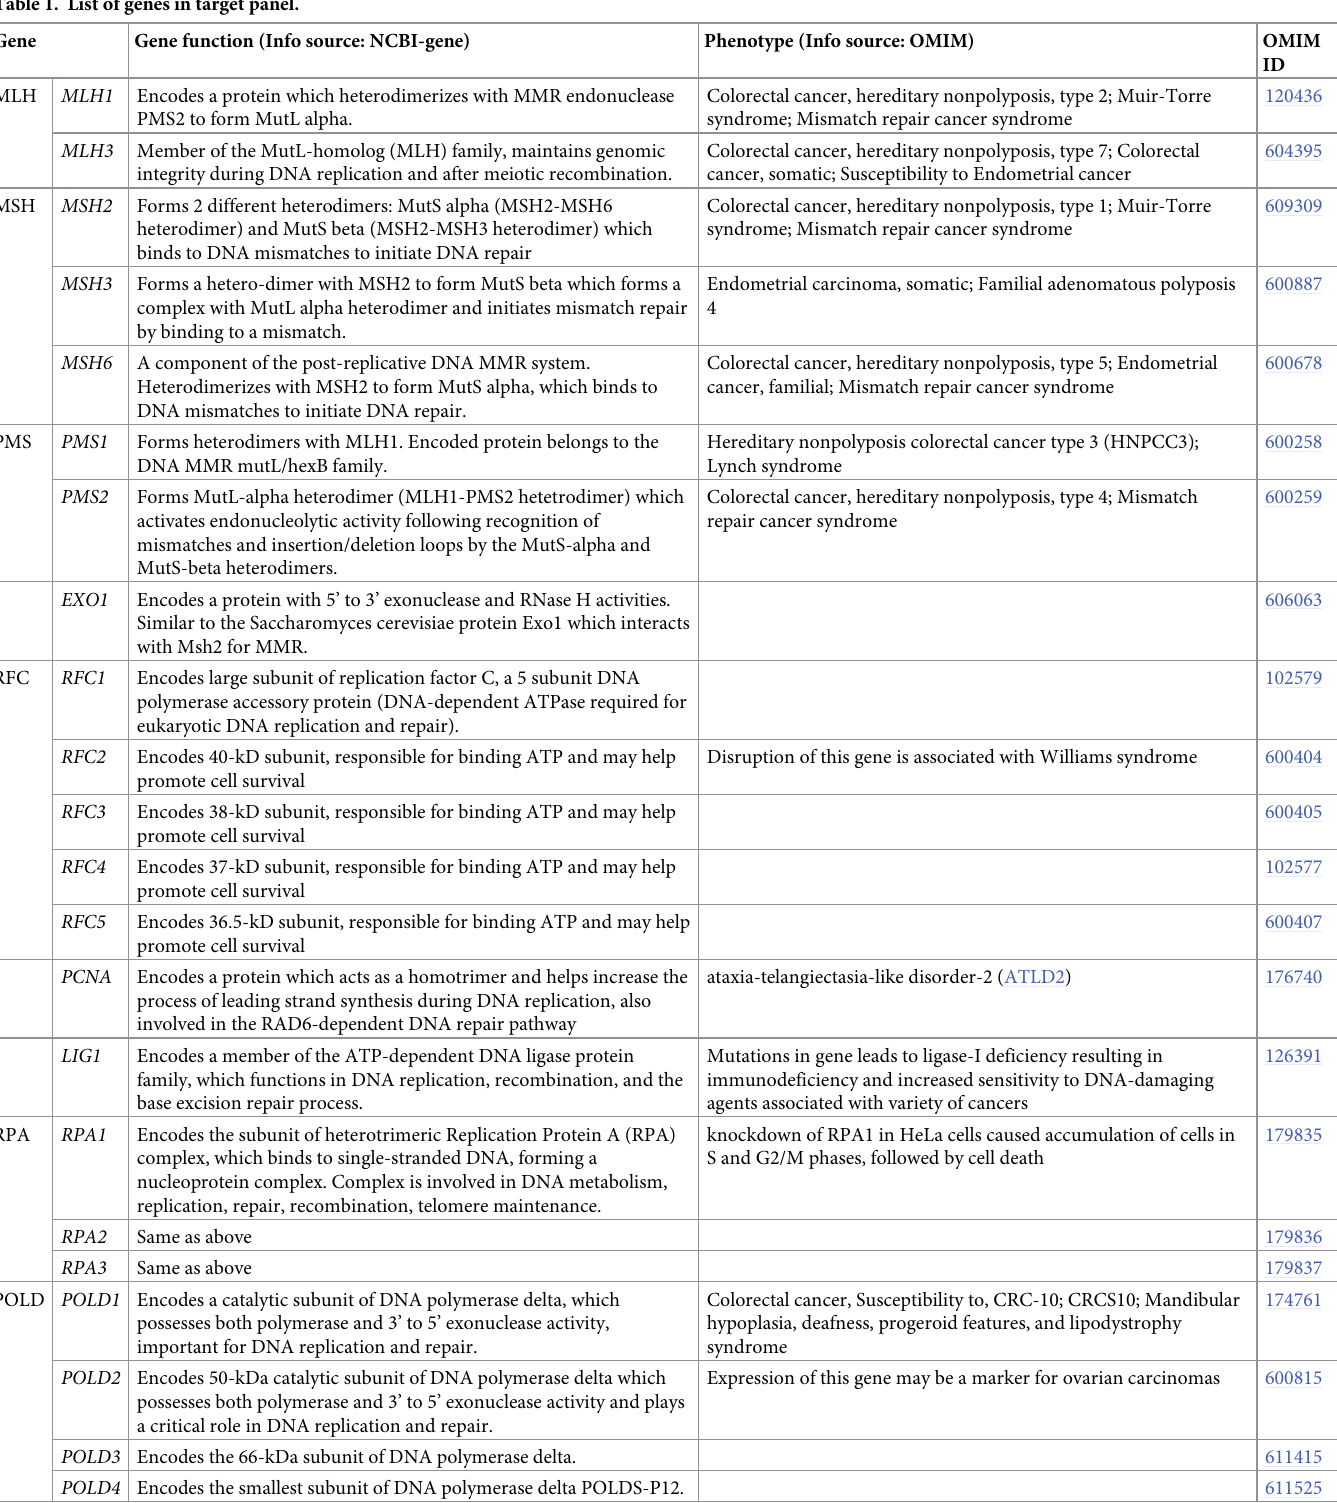
Table 1. List of genes in target panel.